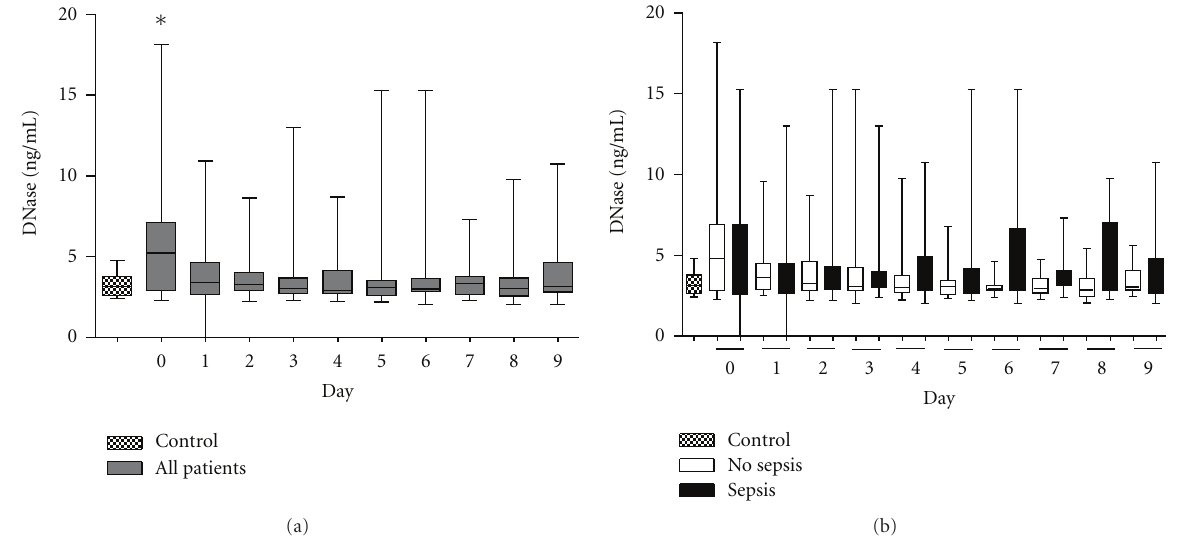
Figure 2: Kinetics of DNase after major trauma. (a) DNase values in patients ( n = 39) were significantly elevated early after trauma ( ∗ P < 0 . 05 versus control group). (b) DNase levels in patients who developed sepsis during the first 10 days after trauma ( n = 14) did not show any di ff erences compared to the values determined in patients with uneventful recovery ( n = 25) or control group (healthy volunteers). The horizontal line across the boxplots represents the median, and the lower and upper ends of the boxplots are the 25th and 75th percentiles, respectively. Whiskers indicate the minimum and maximum values,